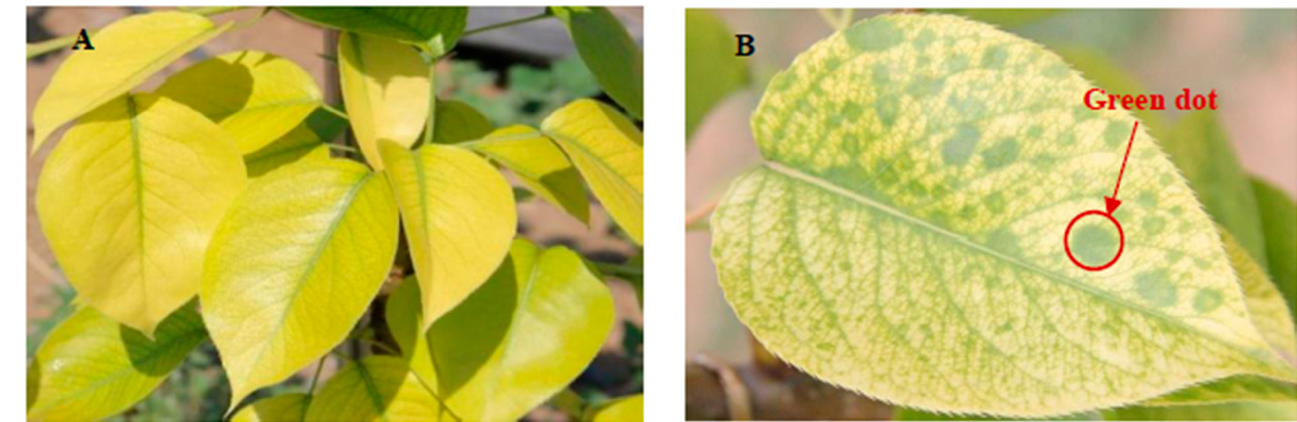
Figure 1. Leaves’ color of “Huangguan” pear grafted onto quince A grown in pear research base of Beijing with calcareous soil ( A ) and the green dots in pear leaves caused by a foliar Fe application ( B ).